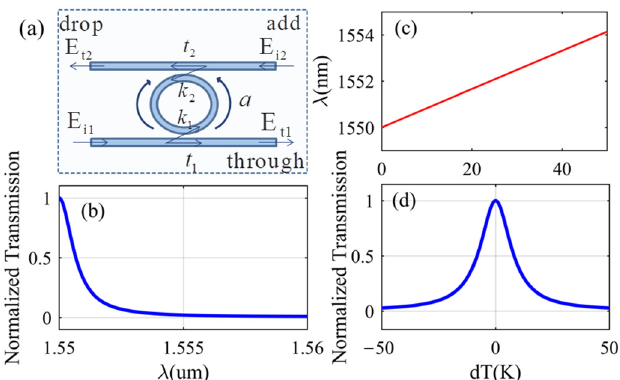
Figure 8. A basic structure of the add-drop MRR ( a ). The transmission of drop port as a function of input light wavelength ( b ). The resonant wavelength as a function of temperature shift ( c ). The transmission of the drop port indicates weight configuration as a function of temperature shift ( d ).